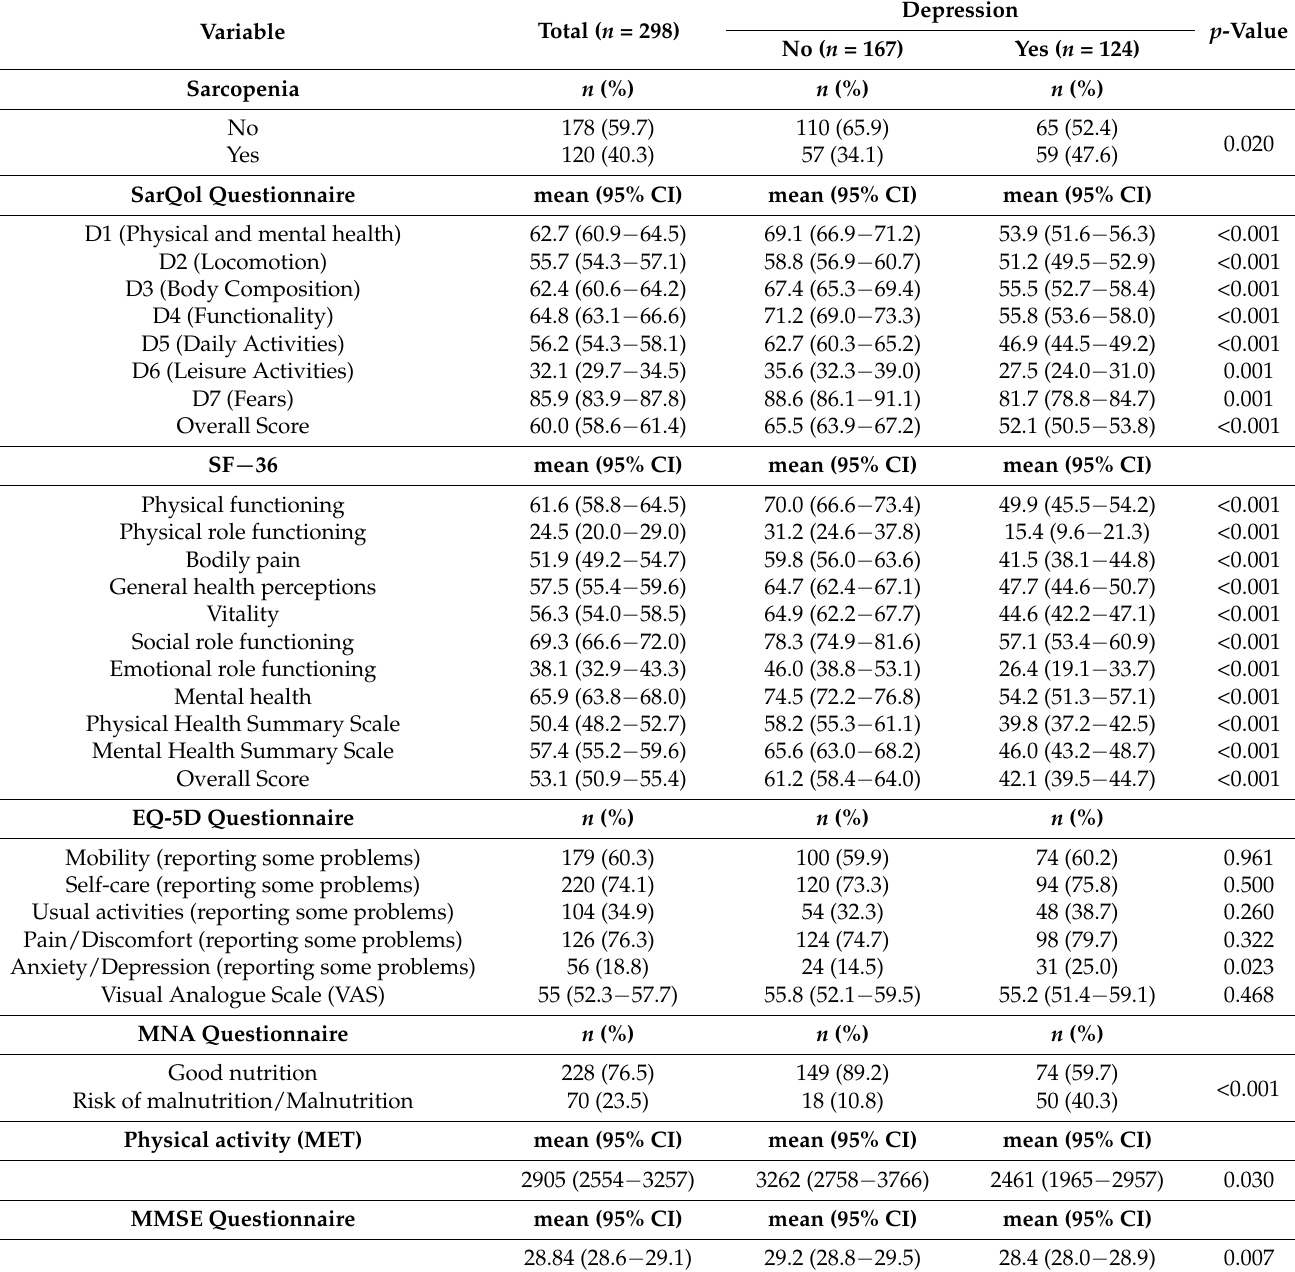
Table 2. Sarcopenia, quality of life, malnutrition, physical activity, and cognitive decline, total and according to depressive symptoms in the